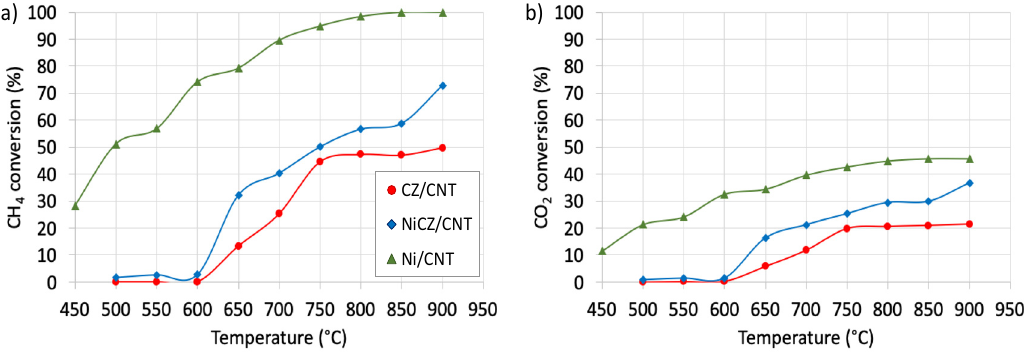
Figure 8. CH 4 ( a ) and CO 2 ( b ) conversion during DRM on CZ/CNT, NiCZ/CNT and Ni/CNT catalysts.